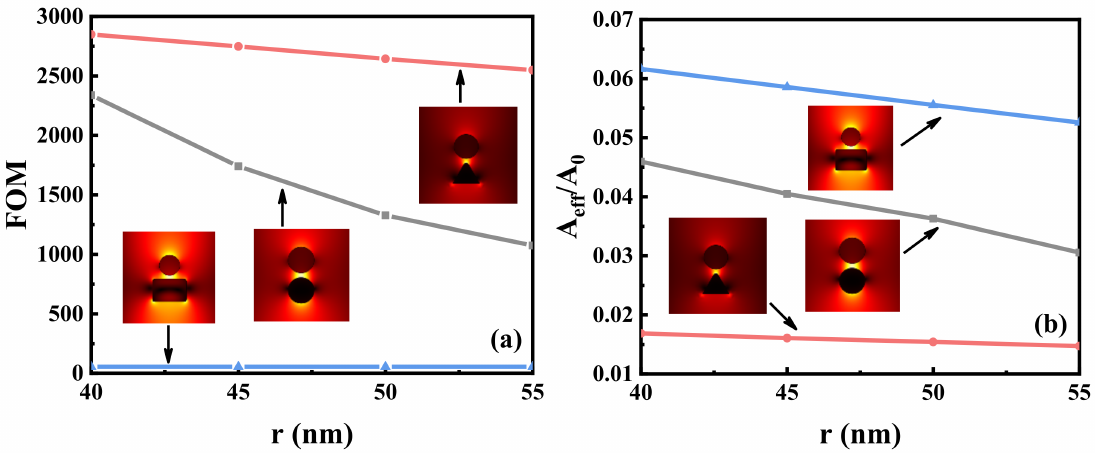
Figure 10. Propagation properties versus the radius of Si waveguide r in a triangle (red line), cylinder (gray line), rectangle (blue line) hybrid waveguides: ( a ) FOM; ( b ) A ef f / A 0